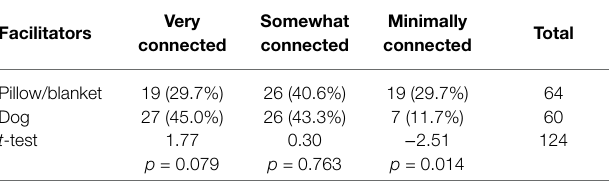
TABLE 2 | Facilitators’ reported connectness with participants for dog and pillow/blanket groups.